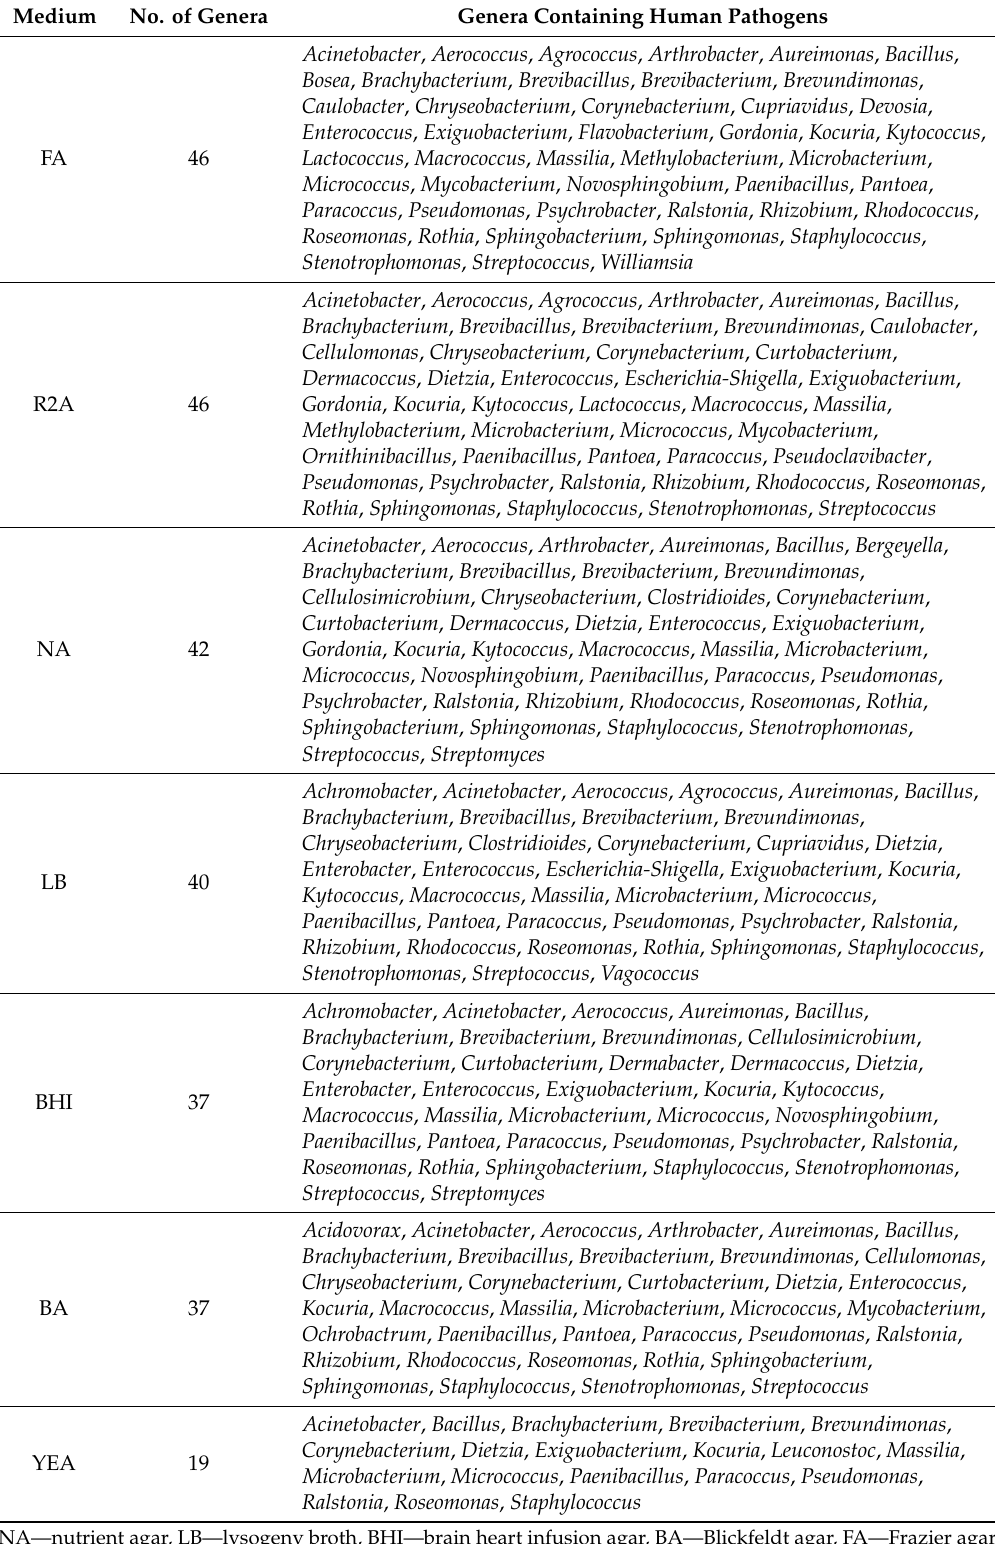
Table 3. Summary of the bacterial genera containing human pathogens that were recovered on various